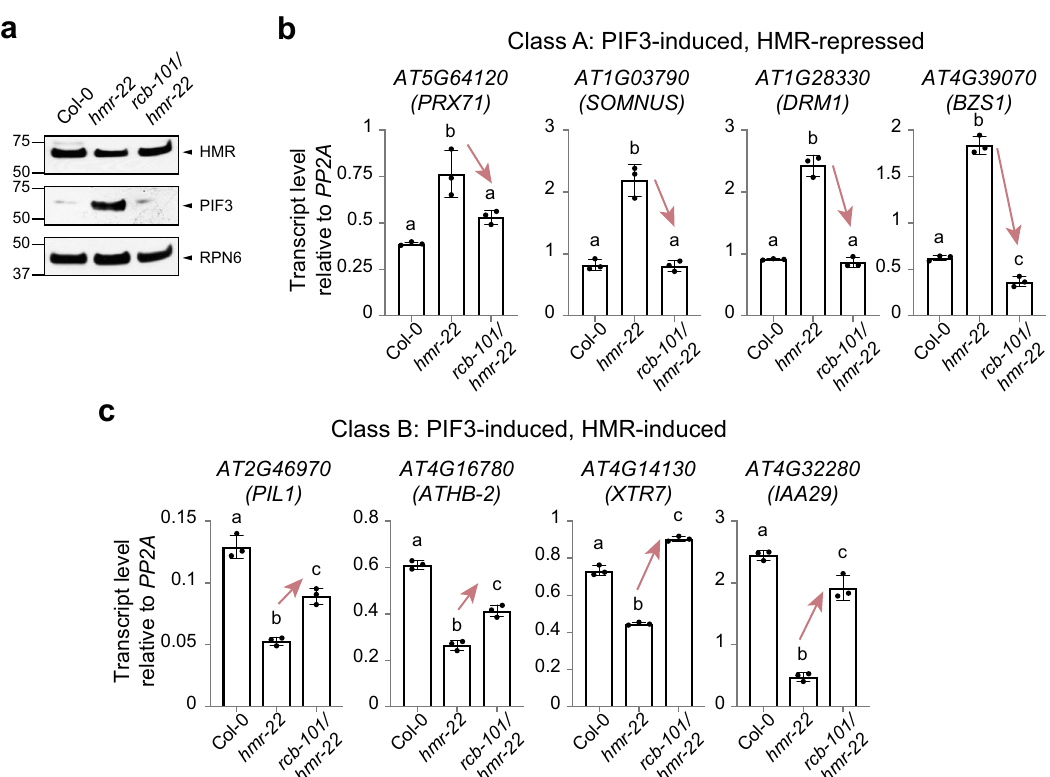
Fig. 3 rcb-101 rescues hmr-22 ’ s defects in photomorphogenesis. a Immunoblots showing the levels of HMR and PIF3 in 4-d-old Col-0, hmr-22 , and rcb- 101/hmr-22 seedlings grown in 10 μ mol m − 2 s − 1 R light at 21 °C. The immunoblot experiments were independently repeated at least three times, and the results of one representative experiment are shown. b , c qRT-PCR analyses of representative class A ( b ) and B ( c ) genes in 4-d-old Col-0, hmr-22 , and rcb- 101/hmr-22 seedlings grown in 10 μ mol m − 2 s − 1 R light at 21 °C. Transcript levels were calculated relative to those of PP2A . Error bars represent the s.d. of three biological replicates. The centers of the error bars represent the mean values. Different letters denote statistically signi fi cant differences in transcript levels (ANOVA, Tukey ’ s HSD, p < 0.05, n = 3). The source data of the immunoblots in ( a ) and the qRT-PCR data in ( b , c ) are provided in the Source Data fi